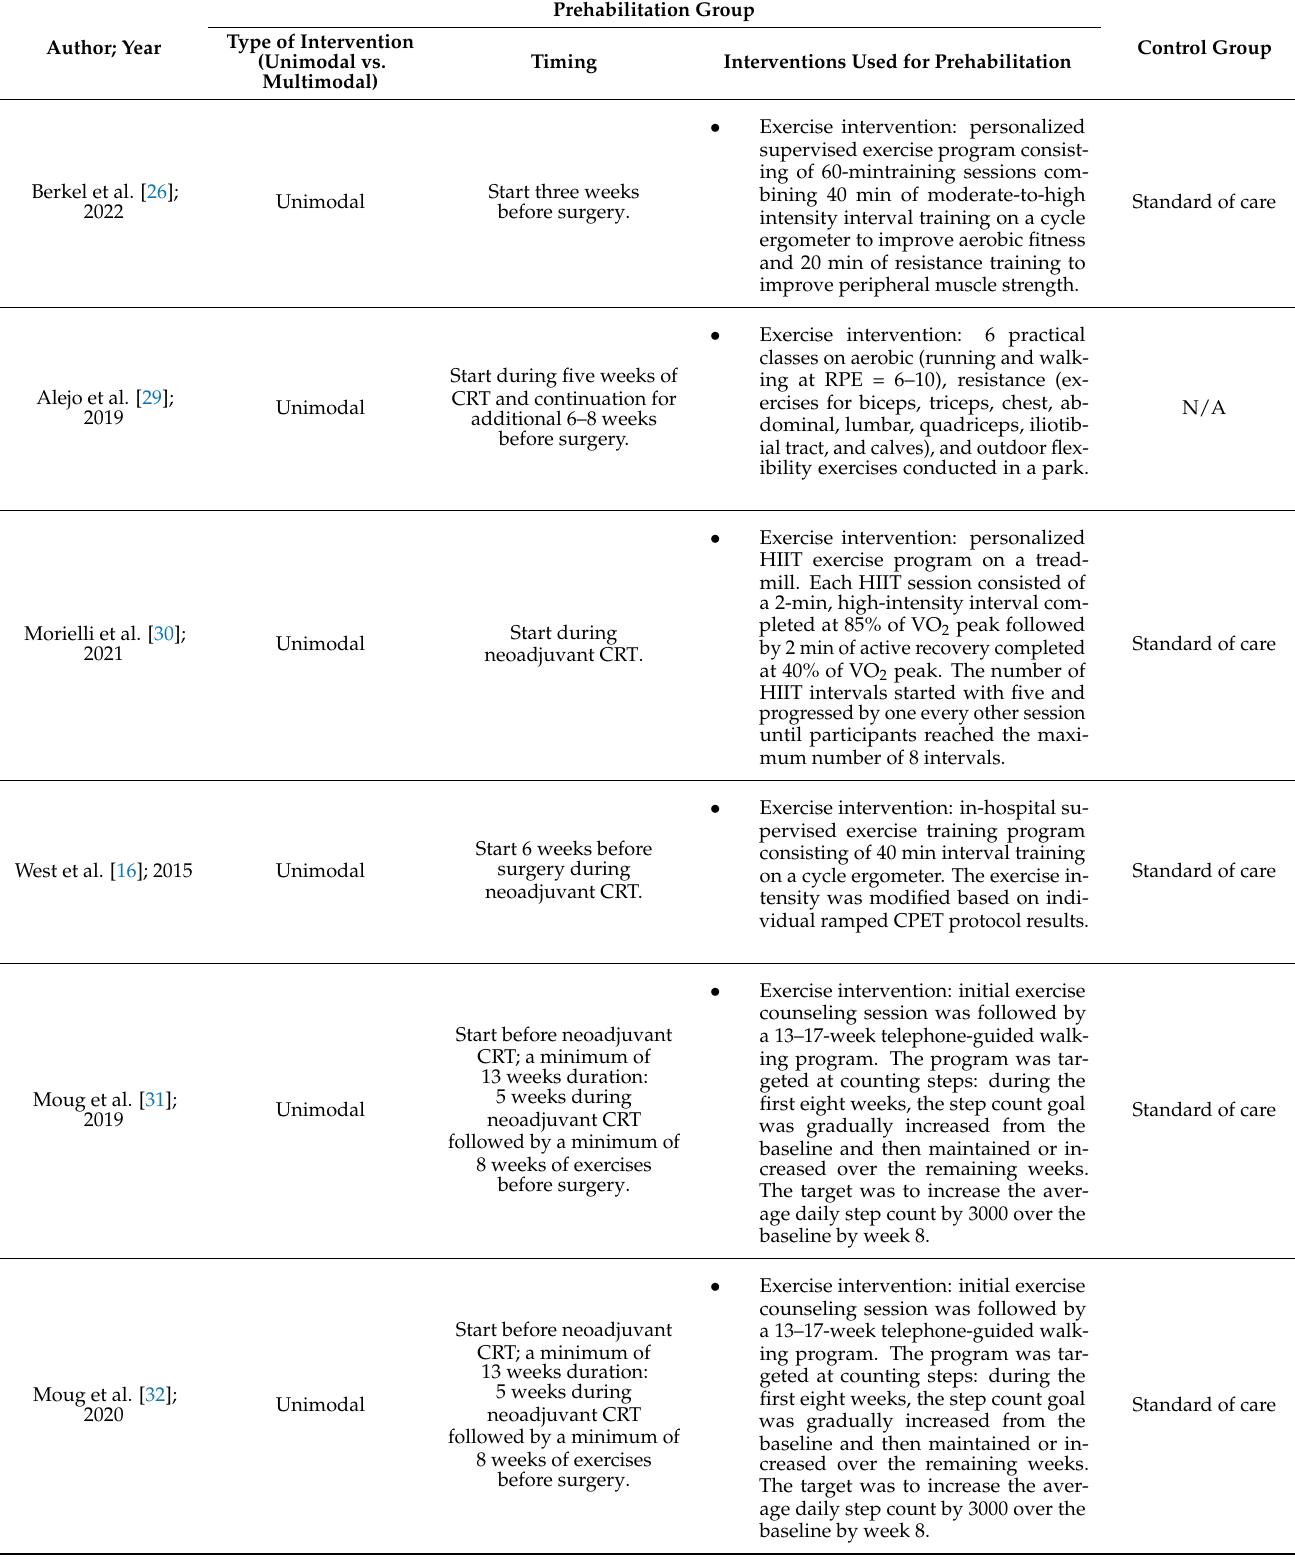
Table 1. Details on interventions in colorectal cancer surgery prehabilitation